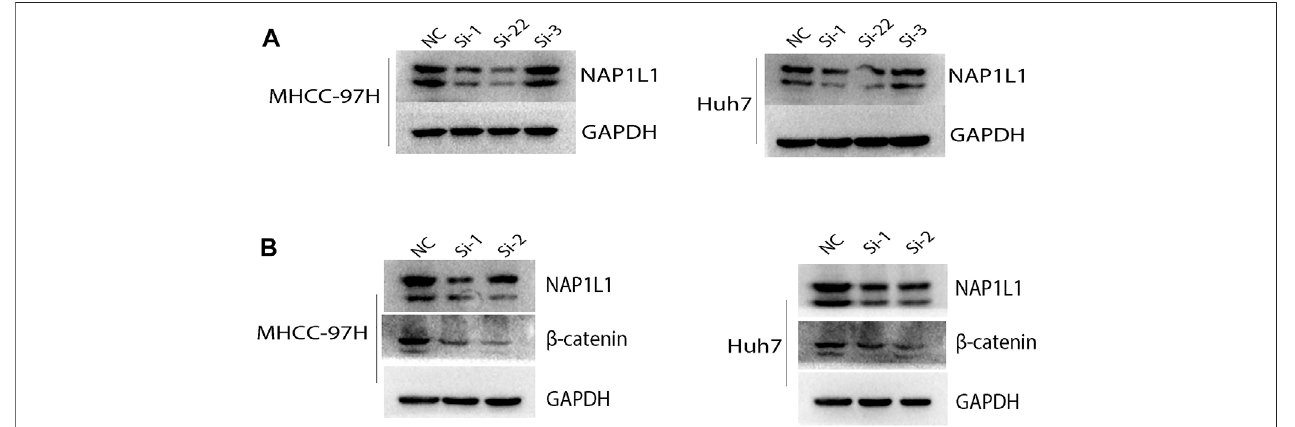
FIGURE 6 | The Western blot: (A) the Western blot was utilized to check the expression level of NAP1L1 among the NC, si-1, si-2, and si-3 groups in MHCC-97H and Huh7 cells, and (B) the Western blot was utilized to examine the expression of NAP1L1 , β -catenin , and GAPDH